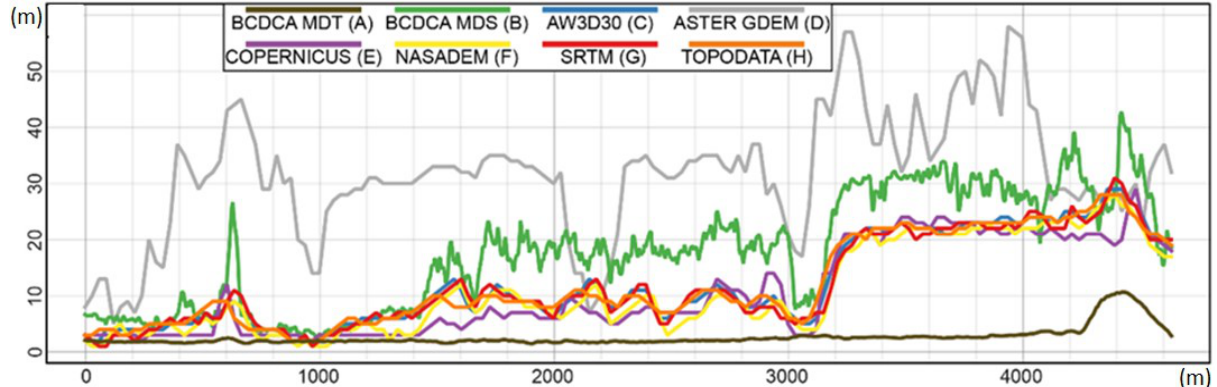
Figure 5. Elevation profiles of different DEMs in a floodplain in area C. The black profile (A) representing the P-band radar DTM analysed in this study is compared with the X-band radar DSM (B), the ALOS WORLD 3D DEM (C), ASTER GDEM v3 (D), the Copernicus DEM (E), The NASADEM (F), SRTM (G) and Topodata (H)